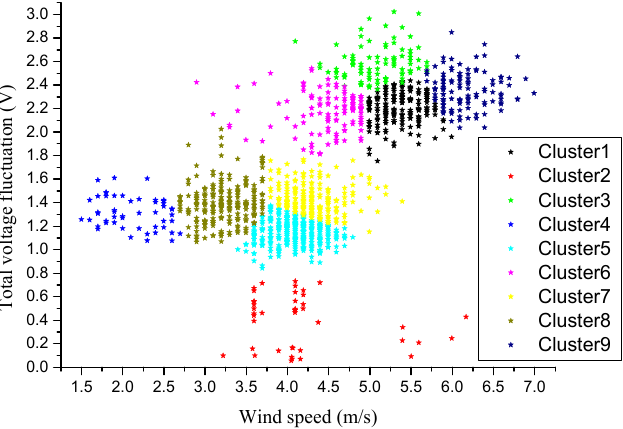
Figure 9. The clustering result with 1500 data segments (k = 9). Table 9. Cluster center (k = 9).